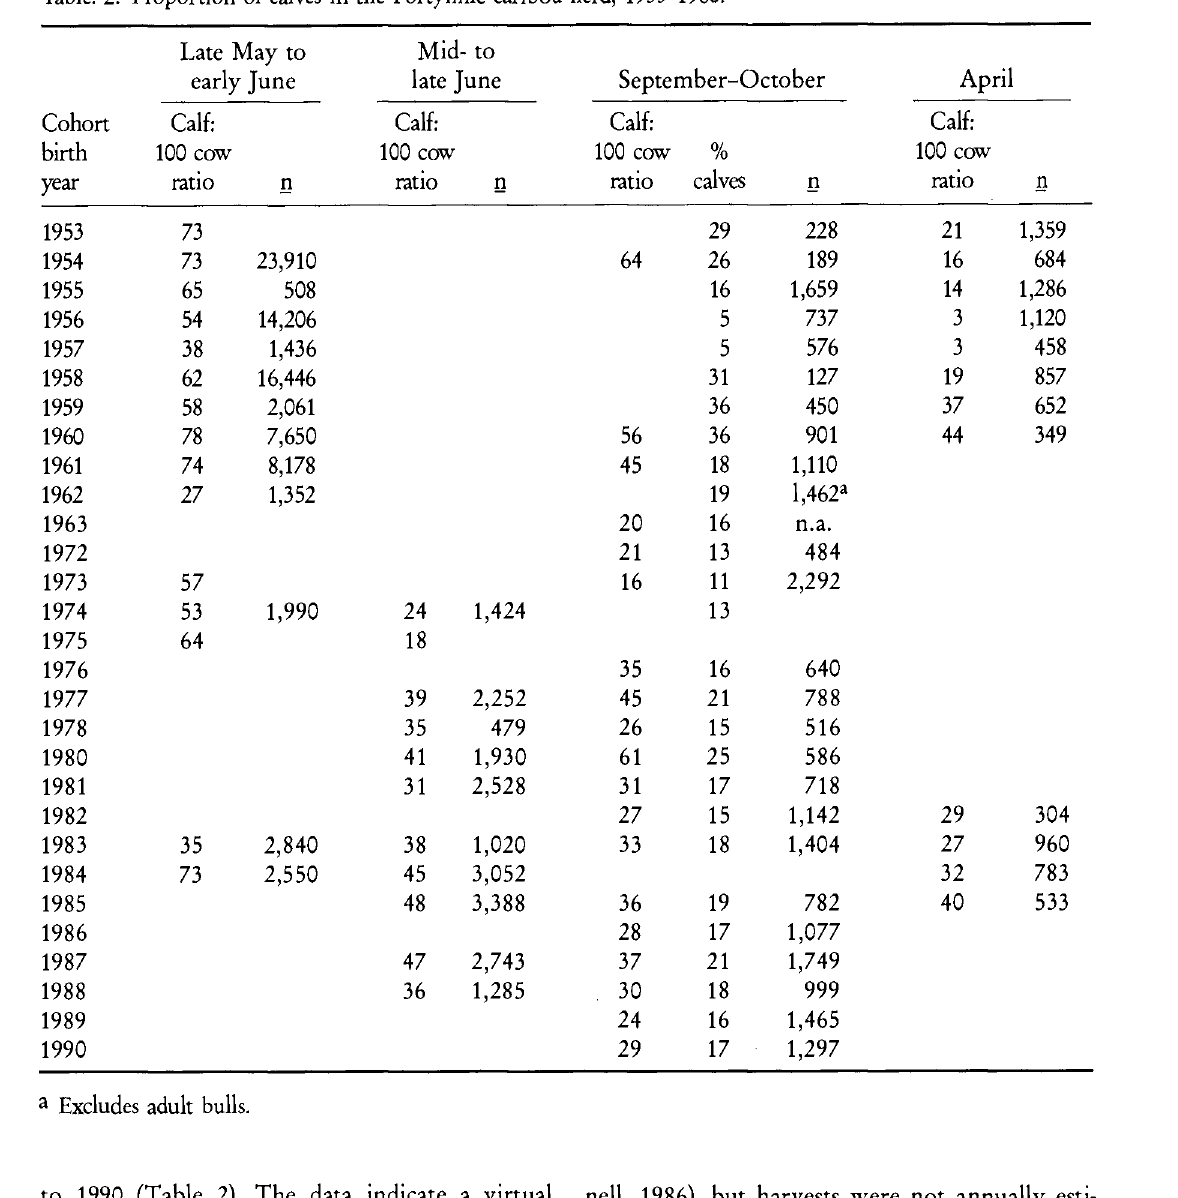
Table. 2. Proportion of calves in the Fortymile caribou herd,